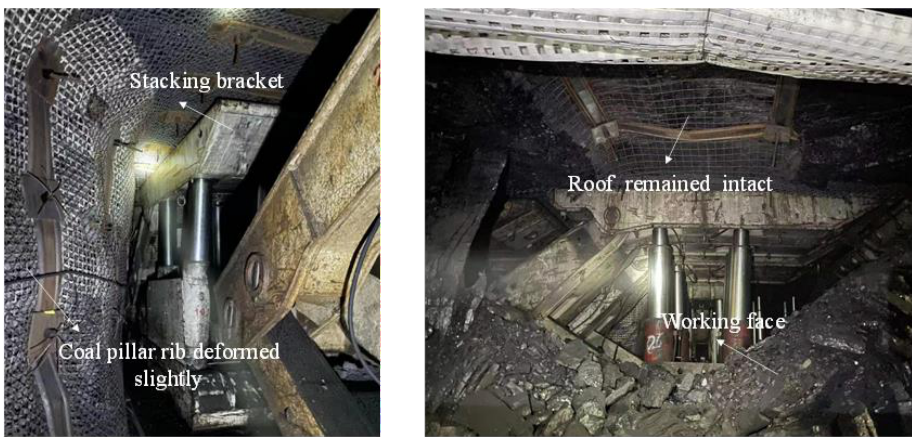
Figure 18. Illustration after the evacuation channel is completed.